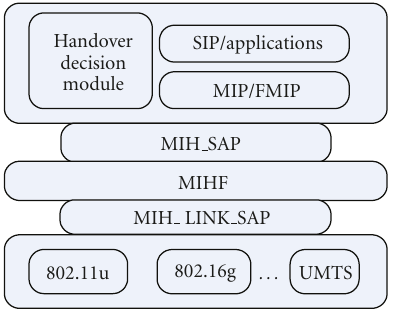
Figure 1: Multiprotocol architecture in heterogeneous